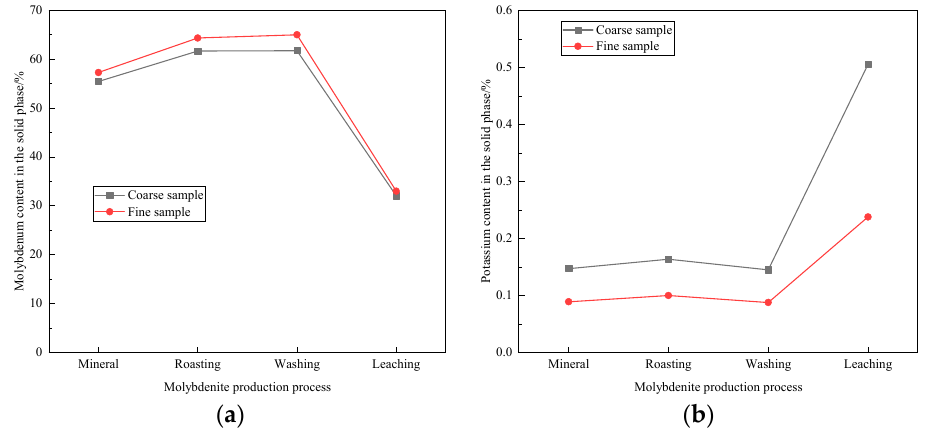
Figure 12. Variation of element content in samples with different particle sizes. ( a ) Mass fraction change of Mo; ( b ) mass fraction change of K.